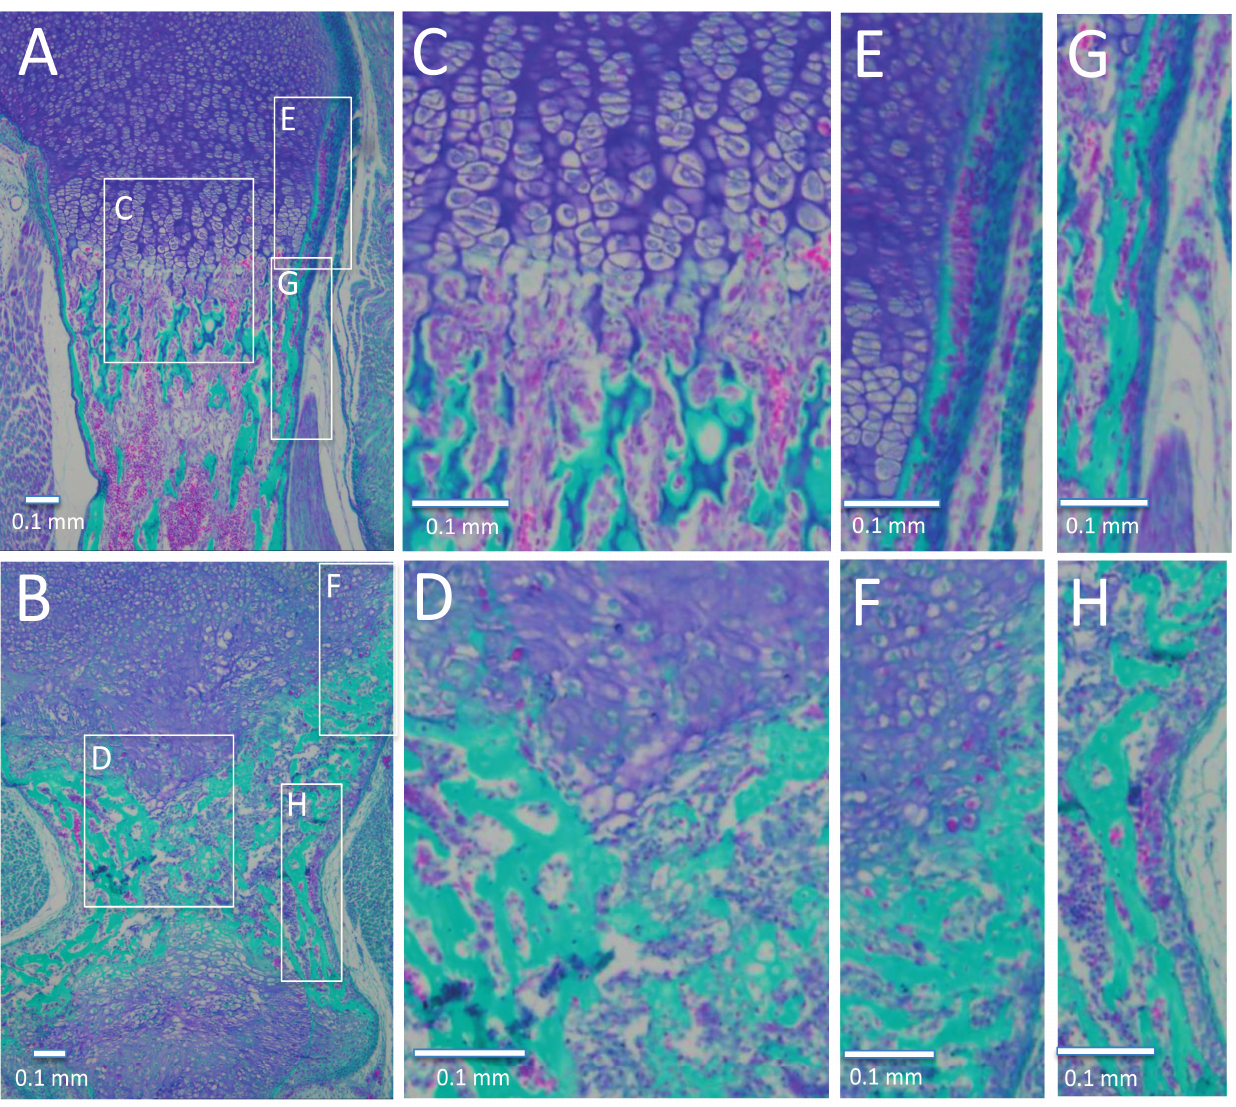
Figure 7. Histological differences in the humeri of WT and Col11a1-deficient mice. ( A , C , E , G ) WT; ( B , D , F , H ) Col11a1-deficient mice. Trichrome staining was used to identify mineralized tissue (green), compared to cartilage tissue (blue). ( A and B ) Upper and lower hypertrophic and mineralized zone, with diaphysis and both growth plates shown for the Col11a1-deficient humerus. ( C and D ) Transition from hypertrophic to mineralized zone demonstrating altered hypertrophic cell size, a more abrupt transition from hypertrophic cartilage to mineralized tissue, and altered bone deposition. ( E and F ) Newly formed bone collar adjacent to the upper hypertrophic region demonstrates a thicker mineralized region adjacent to the cartilage in the mutant compared to WT. ( G and H ) Bone collar near the diaphysis from WT and Col11a1-deficient mice. Scale bars = 0.1